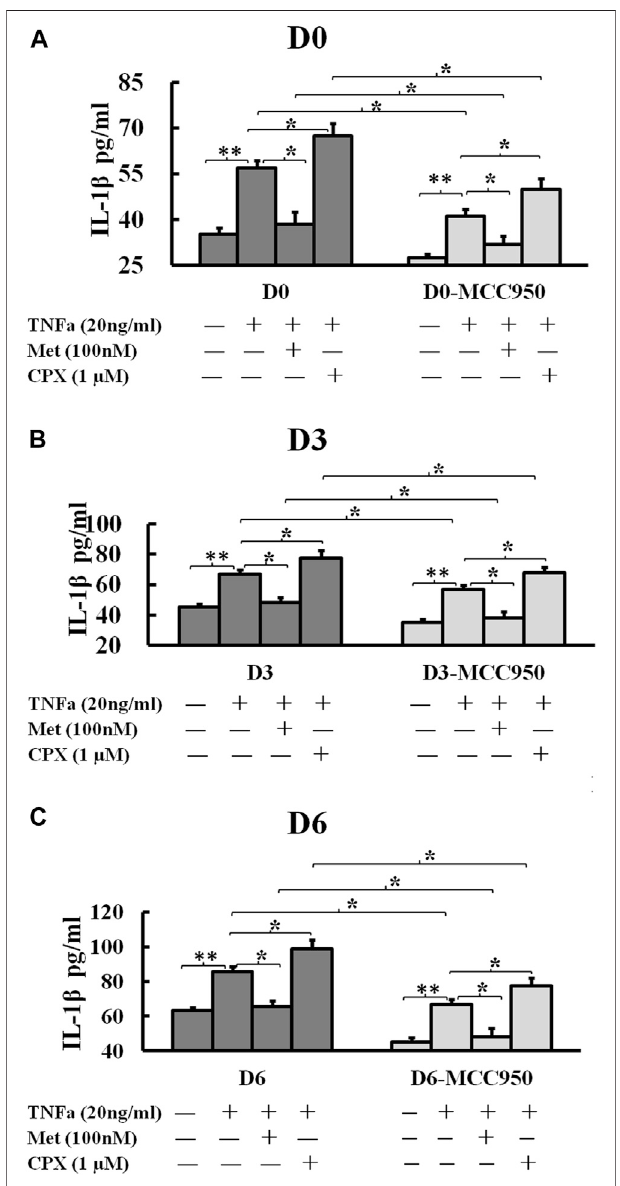
FIGURE 6 | Histamine H 3 receptor modulates the secretion of IL-1 β . C2C12 cells were incubated in the presence of TNFa (20 ng/ml), TNFa + Met (100 nM) or TNFa + CPX (1 µM) or MCC950 (1 µM) for 24 h at D0, D3, or D6. The mature IL-1 β protein secretions were assessed byELISA.* p <